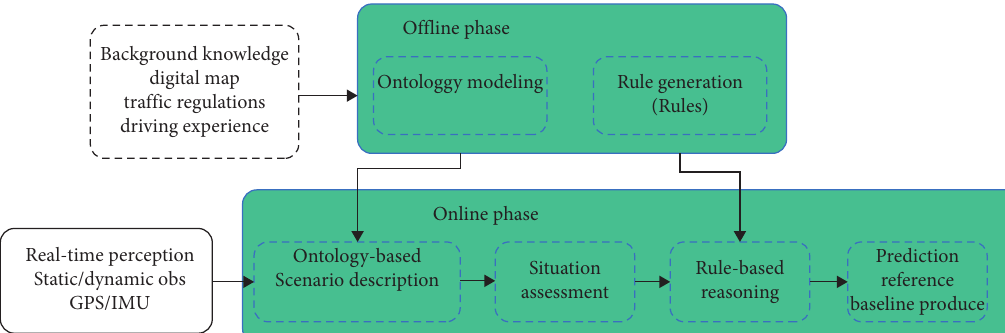
Figure 4: Overview of the proposed trajectory prediction model.